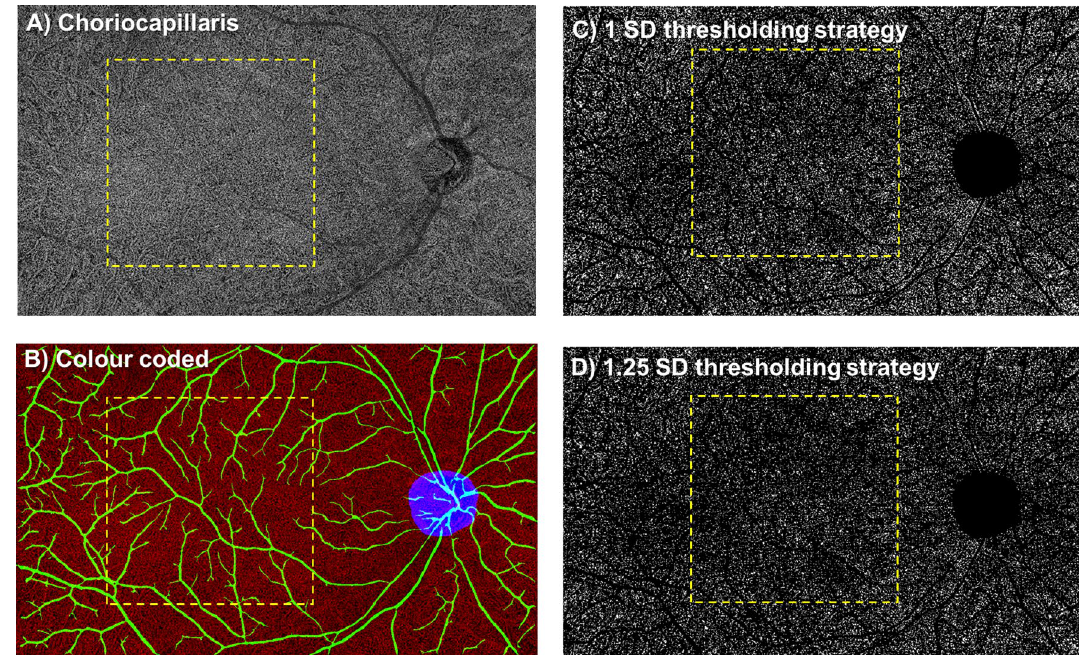
Figure 5. The choriocapillaris image ( A ) was processed to obtain the choriocapillaris flow void metrics using either ( C ) 1 standard deviation (SD) or ( D ) 1.25 SD thresholding algorithms. The choriocapillaris angiogram was first inverted and then thresholded. In the colour coded image ( B ), pixels with an intensity over the applied threshold are marked in red and those pixels below the threshold are marked in black. Also, the optic disc (blue) was manually masked and large vessels (green) were automatically removed for flow void calculation. There were fewer flow voids (seen as bright white speckles) when a larger threshold was used. Flow void metrics were investigated in 2 different regions of the choriocapillaris slab: (1) the macular region (within yellow dotted box) with a 6 × 6-mm 2 region centred over the fovea and (2) the peripheral region (outside the yellow dotted box). Image A was generated from the built-in review software (PLEX Elite Review Software, Carl Zeiss Meditec, Inc., Dublin, USA; Version 1.7.1.31492; https ://www.zeiss .fr/conte nt/dam/Medit ec/inter natio nal/ifu/docum